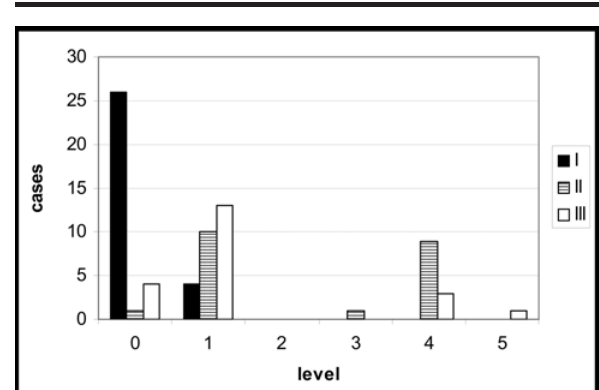
FIGURE 10 - Animals distribution in relation to the adhesion level, according to the studied group. I.